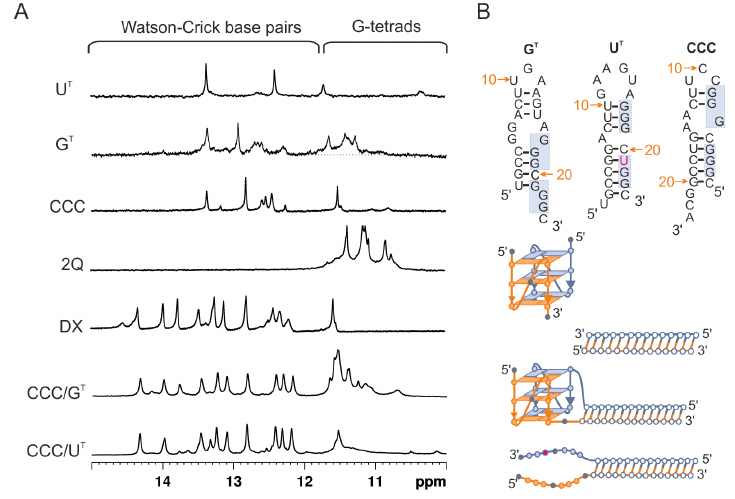
Figure 2. The imino region of the 1 H NMR spectra of U T , G T , CCC, 2Q, DX, CCC/G T , and CCC/U T , recorded in 90% H 2 O/10% D 2 O ( v / v ) in the presence of 50 mM KCl, 10 mM potassium phosphate, and 0.1 mM EDTA, pH 6.8; 25 °C ( A ). Proposed secondary structures (2Q, QDH, Dss) and predicted by RNAstructure (hairpins, DX) ( B ).